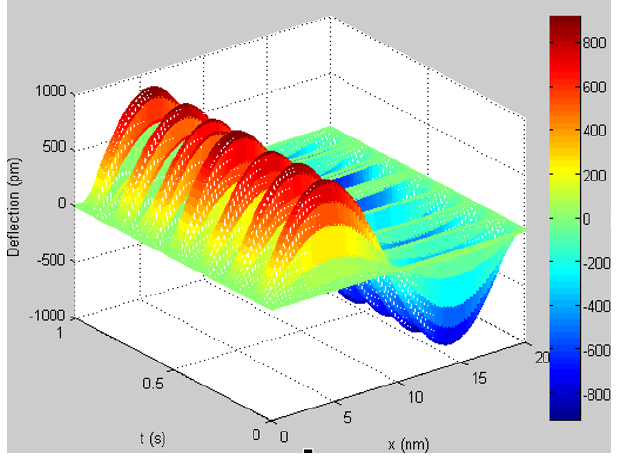
Figure 5. Dynamic response of the SWCNT for mode 2